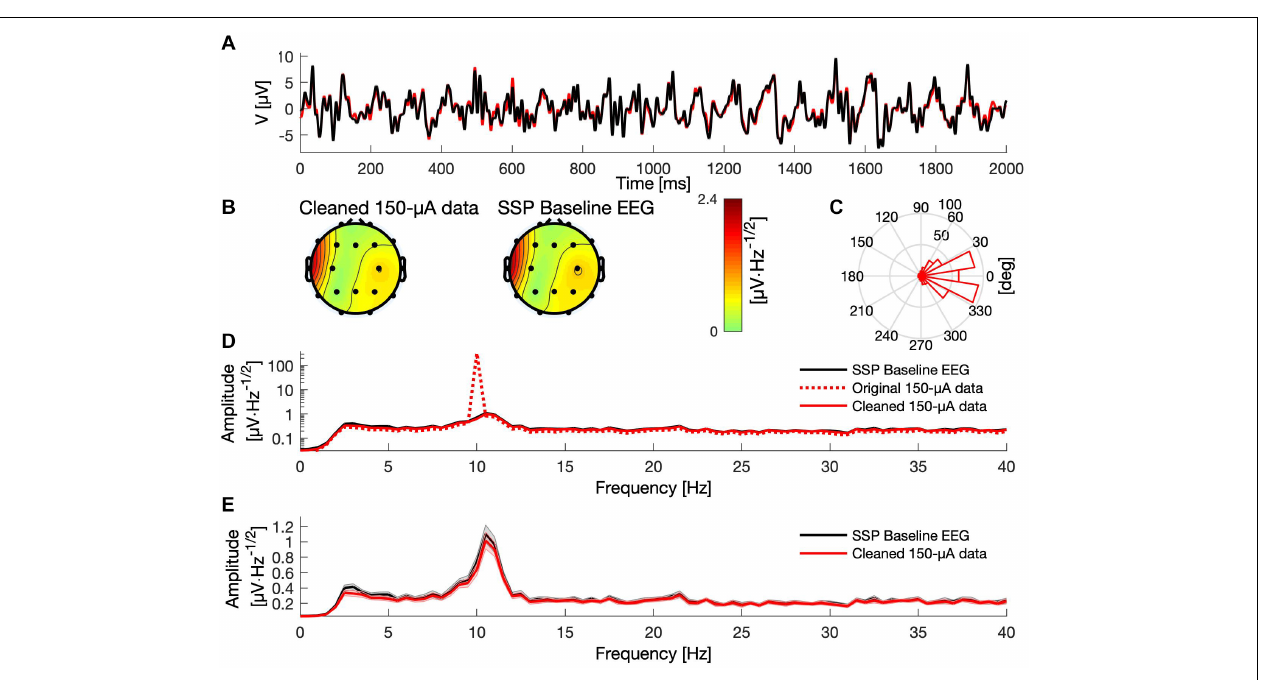
FIGURE 4 | Comparison between baseline and SSP-cleaned data when delivering tACS with 150 µ A. (A) A 2-s segment of baseline (black) and cleaned data (red) measured at electrode Pz. (B) Topographies showing the mean signal amplitude between 8 and 12 Hz of the cleaned and baseline data, respectively. (C) Histogram of the phase difference between cleaned artifactual and baseline data at 10 Hz across all epochs and channels. (D) The mean frequency spectra (averaged over epochs) for the baseline (black curve), original artifactual (red dashed curve), and cleaned artifactual data (solid red curve), in channel Pz, presented on logarithmic scale. (E) The mean frequency spectra of the baseline (black) and the cleaned data (red), in channel Pz, presented on a linear scale. Shaded areas indicate the standard error of the